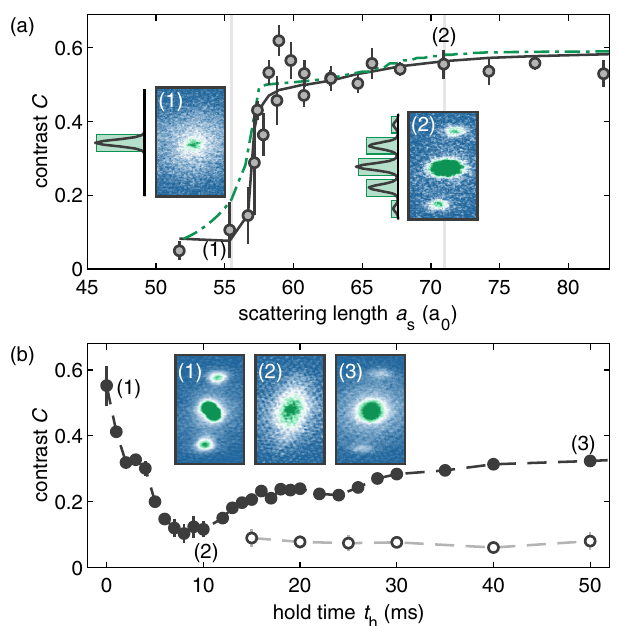
Fig. 3 Interaction-induced localization. a Contrast of the interference pattern after loading the lattice at different a s . The green dot-dashed (black solid) line represents the result of the 1D discrete model (3D extended Gross- Pitaevskii equation, eGPE) multiplied by 0.7. The insets show the respective density distributions along z of the 1D discrete model (bars) and 3D eGPE (lines) and corresponding experimental averaged interference patterns after TOF expansion (1,2). The statistical uncertainties on the scattering length is smaller than the symbols size. b Dynamic evolution of the contrast quenching back ( fi lled circles) or holding a s (open circles); see text. The error bars represent the standard error on the mean over 4 – 6